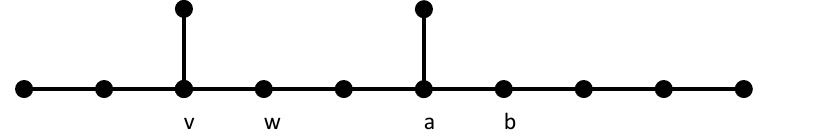
Figure 15: The caterpillar 𝐶 (1 , 1 , 0 , 0 , 1 , 0 , 0 , 1) of odd diameter; p ( 𝑣𝑤 ) = p ( 𝑎𝑏 ) = (1 , 3 , 4 , 5 , 6 , 5 , 4 , 3 , 1) and 𝑒𝑐𝑐 ( 𝑣𝑤 ) ∕ = 𝑒𝑐𝑐 ( 𝑎𝑏